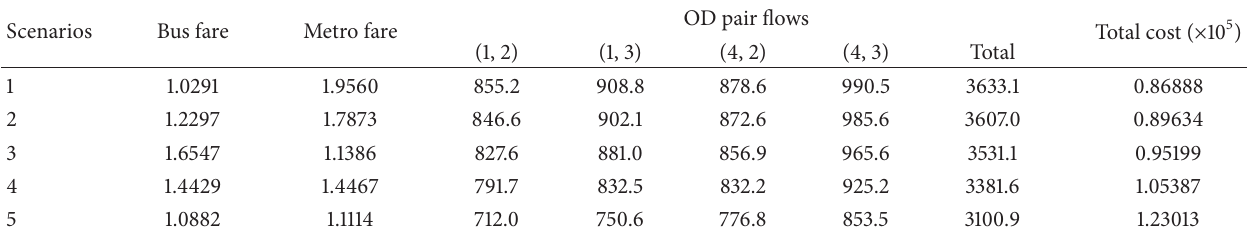
Table 8: Transit fare structure and transit route flows considering different scenarios ( 𝛼 = 5 ). Scenarios